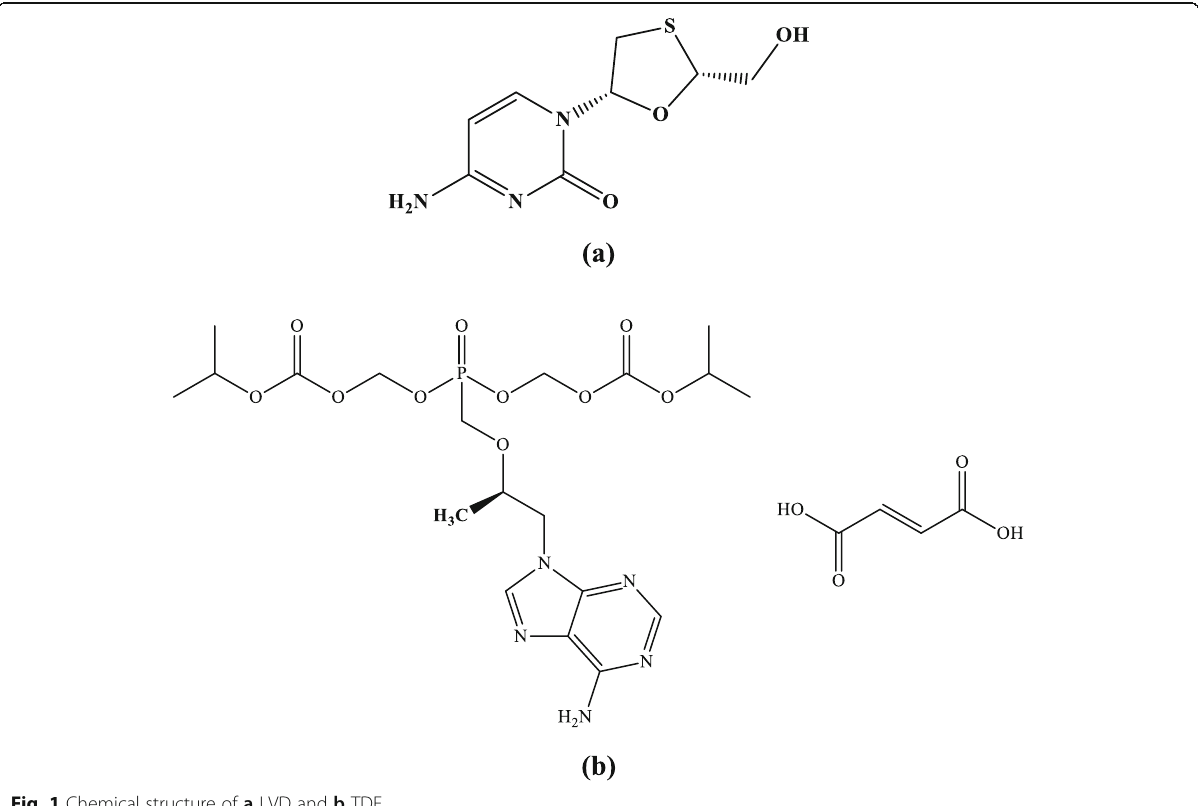
Fig. 1 Chemical structure of a LVD and b